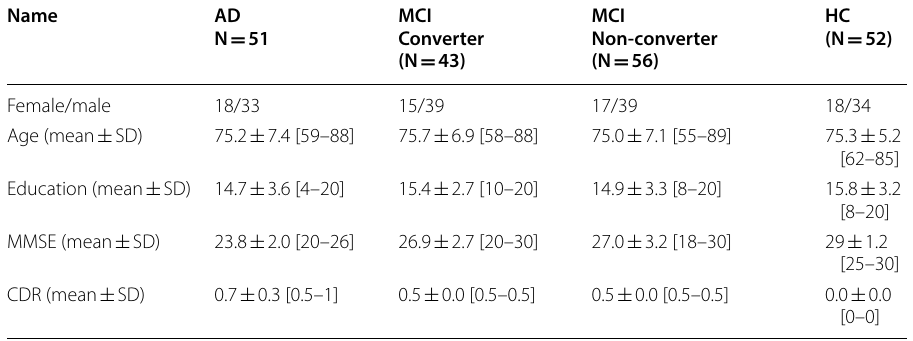
Table 1 Clinical information of the images